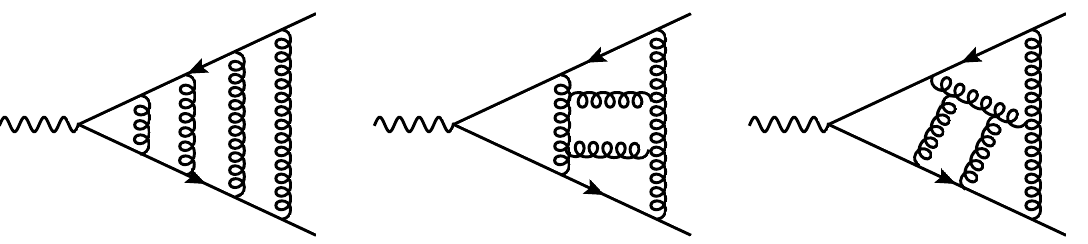
Figure 1 . Sample four-loop Feynman diagrams contributing to F q . Solid, curly and wavy lines represent quarks, gluons and photons, respectively. All particles are